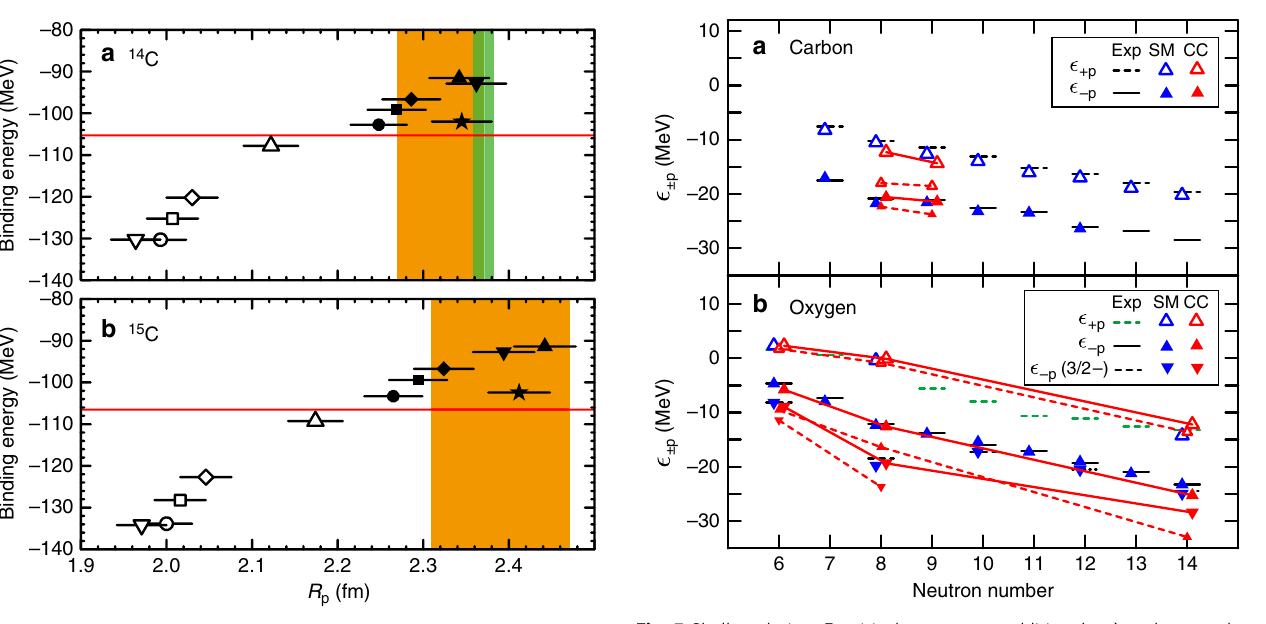
Fig. 4 Binding energies versus proton radii. The results for a 14 C and b 15 C are shown. The coloured bands and red-horizontal lines are the experimental values. The green band represents the proton radius from the electron scattering. The fi lled black symbols are the CC predictions with SRG-evolved NN + 3NF chiral effective interactions at different NN/3NF cutoffs and NNLO sat , whereas the open symbols are the predictions with the NN-only EM and NNLO sat interactions. The error bars are the estimated theoretical uncertainties due to truncations of the employed method and model space 53 . See text for details